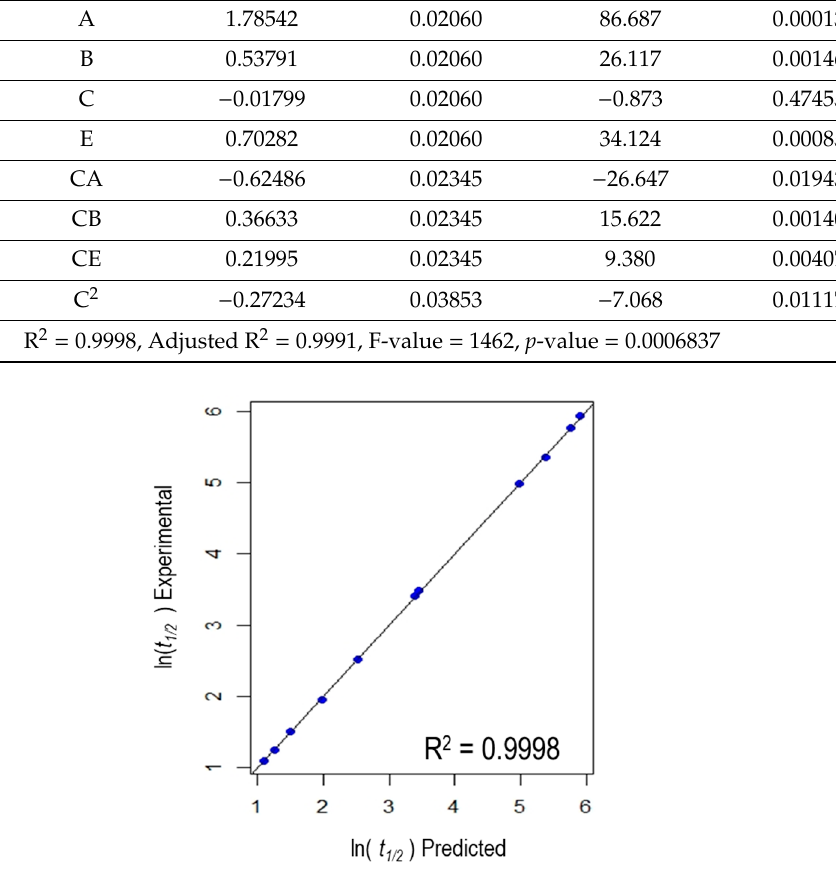
Table 5. Estimates of the regression coefficients of the model described by Equation (2) .